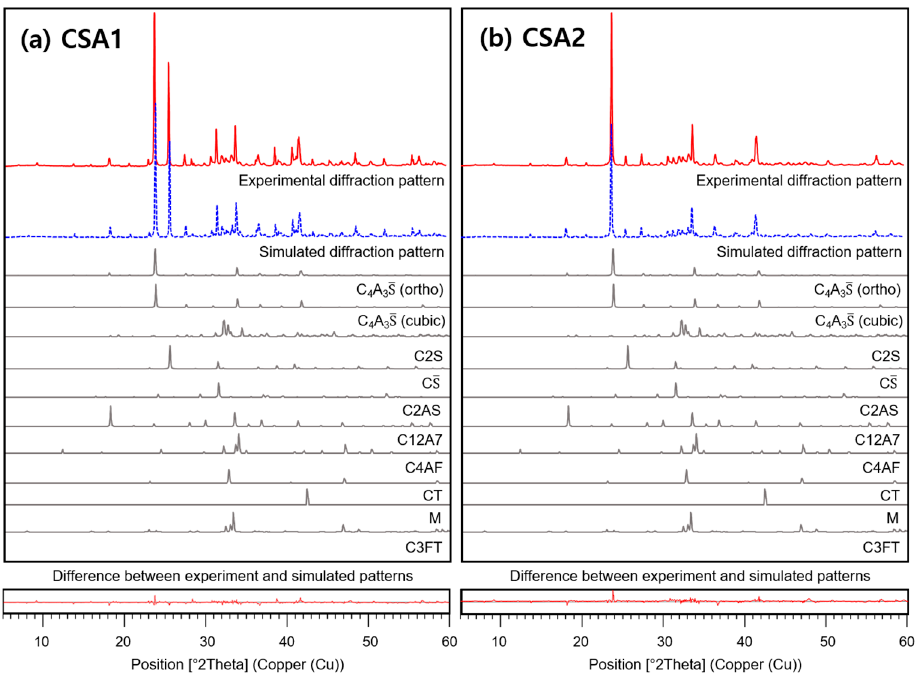
Figure 2. Rietveld refinement results of ( a ) CSA1 and ( b ) CSA2 cements.